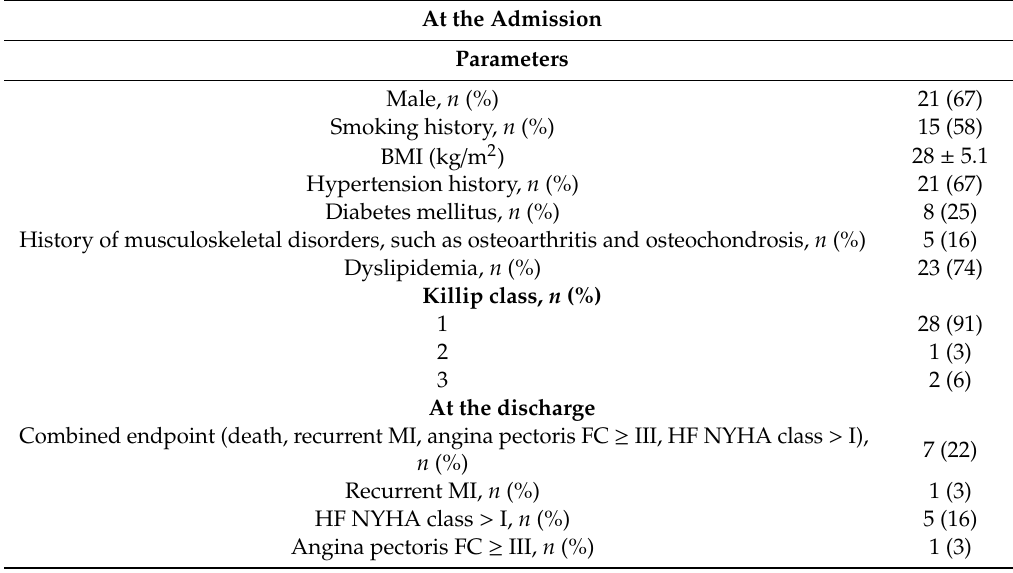
Table 1. Medical history and vital signs of patients with STEMI during the period of hospitalization ( n = 31) [4].